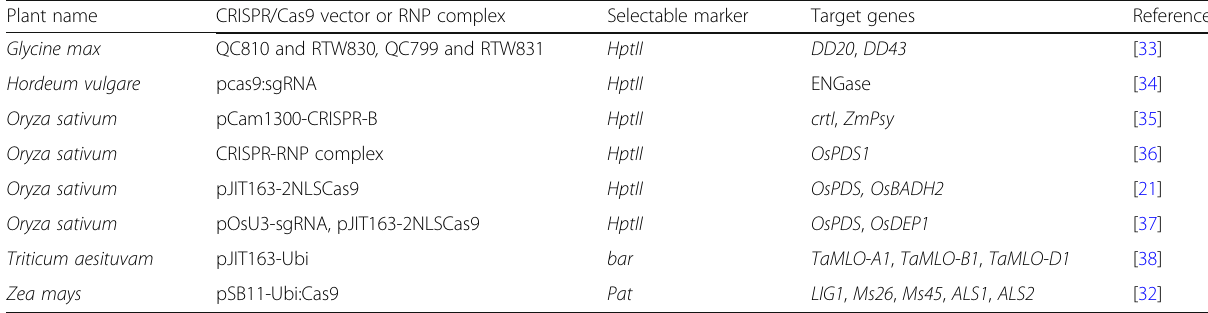
Table 2 Particle bombardment method for CRISPR/Cas9 component delivery Plant